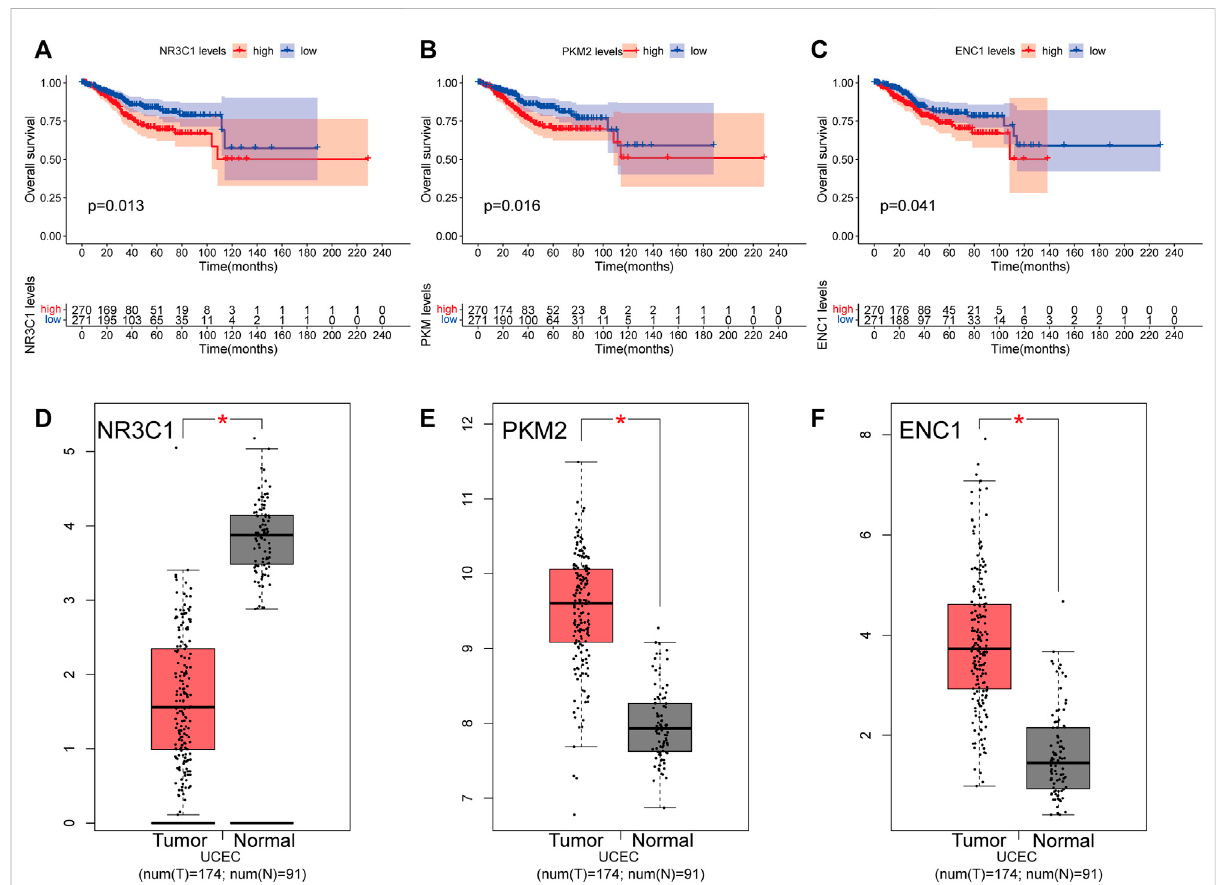
FIGURE 6 Overall survival analyses and transcript levels of genes in UCEC patients. (A) Overall survival analysis was performed using the Kaplan-Meier method for NR3C1 expression in UCEC patients. (B) Kaplan-Meier survival curves for PKM2 expression. (C) Kaplan-Meier survival curves for ENC1 expression (D) Histogram illustrating mRNA expression levels of NR3C1 in the GEPIA database. (E) Histogram depicting the mRNA expression levels of PKM2 in the GEPIA database. (F) Histogram showing the mRNA expression level of ENC1 in the GEPIA database. Red represents tumor tissue, and gray represents paracancerous tissue. * p <